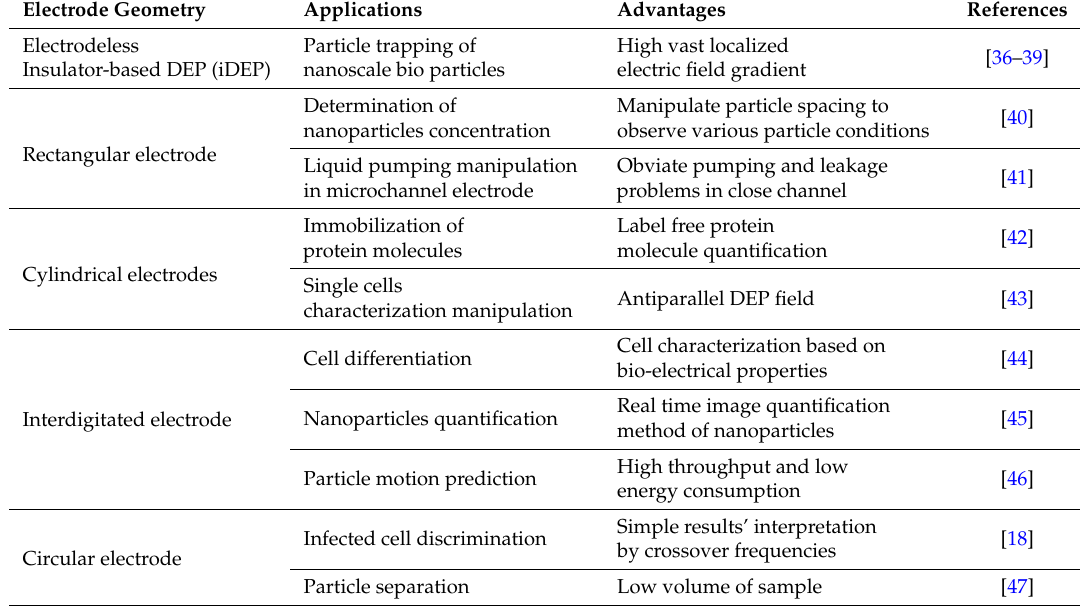
Table 1. Electrode geometries and arrangements used in DEP for biomedical